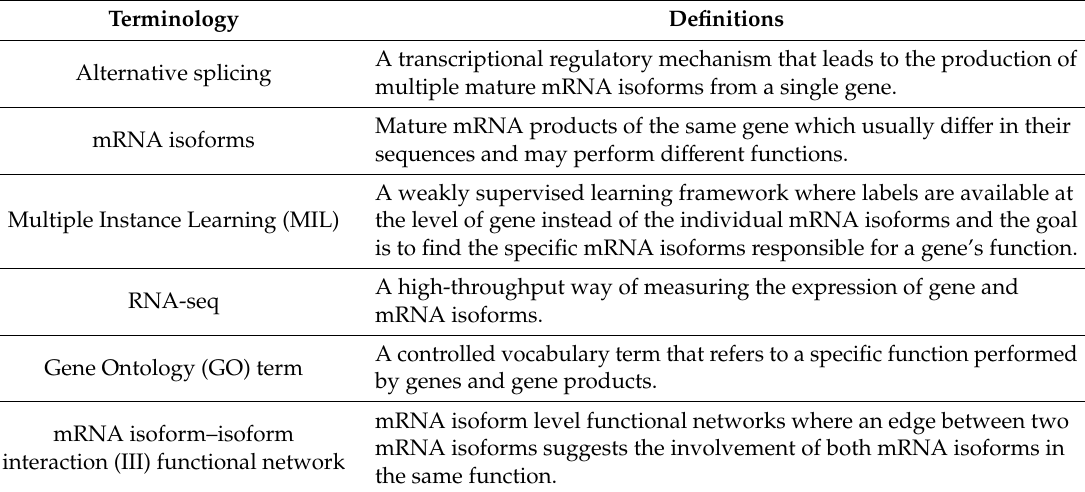
Table 1. Frequently used terminologies and their contextual definitions in the field of mRNA isoform function